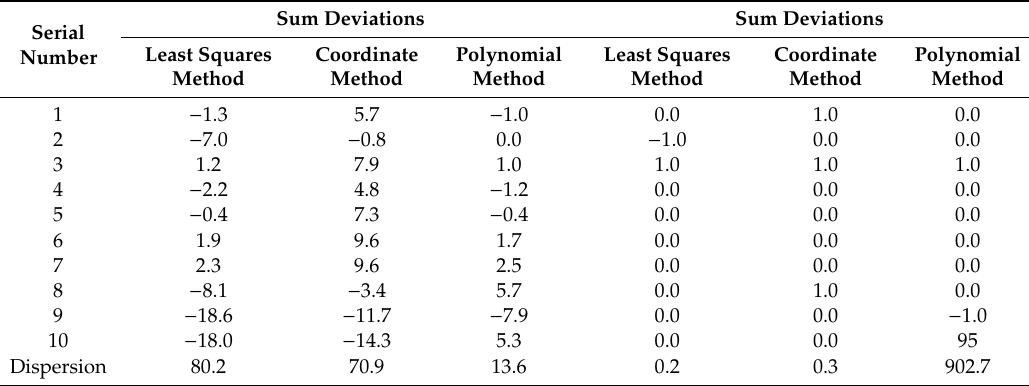
Table 5. Analysis of results achieved by di ff erent